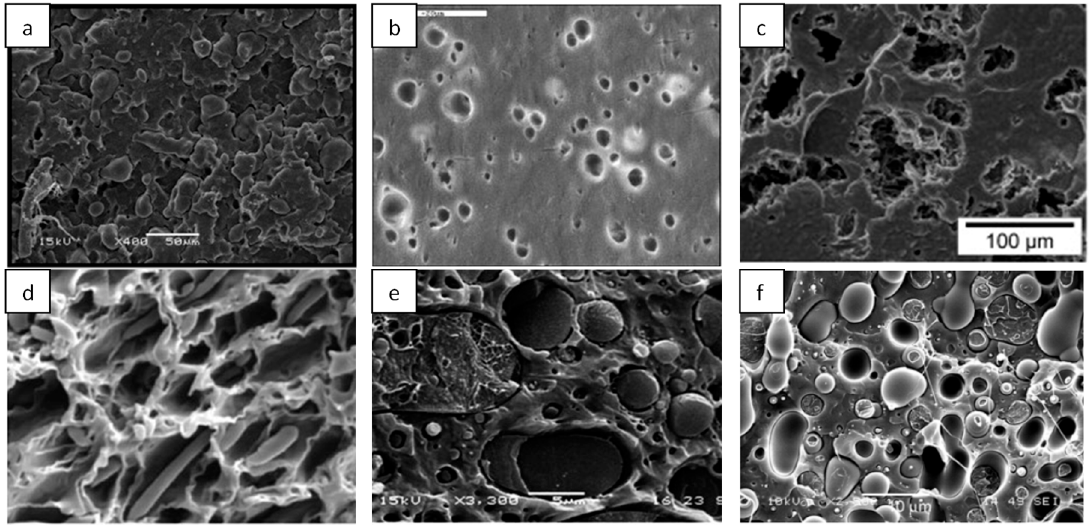
Figure 6. SEM micrographs of ( a ) PP/TPS/MA blend [184]; ( b ) TPS/PE compatibilized with PP-g-MA 20%—scale 20 µ m [186]; ( c ) 30TPS/70PA12 blend [190]; ( d ) LDPE/PHB 80:20—scale 40 µ m [191]; ( e ) PS45/PHB45-(block copolymer) C10 blend [192]; ( f ) PLA/PS (0.3 volume fraction) blend [193] .